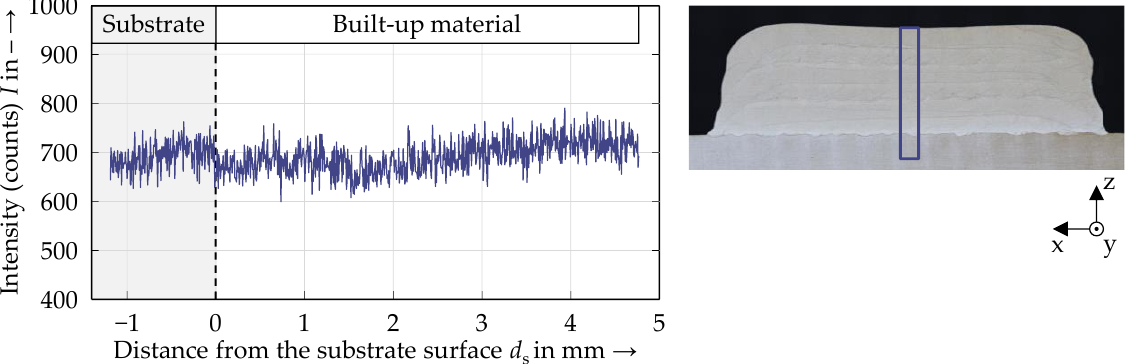
Figure 12. EDS line scan of the oxygen distribution in the built-up cuboid along the z-direction.